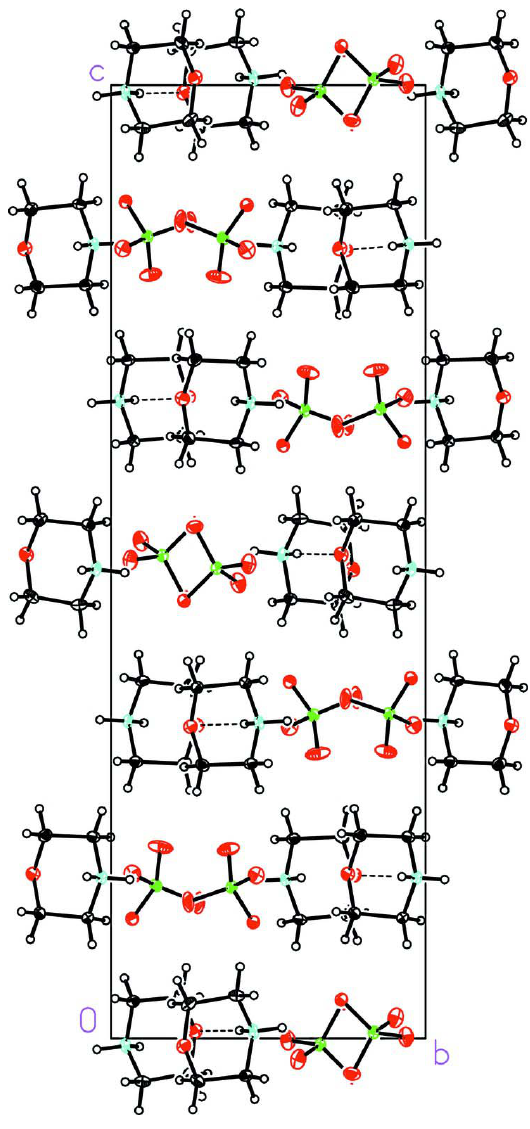
Figure 2 The unit cell of